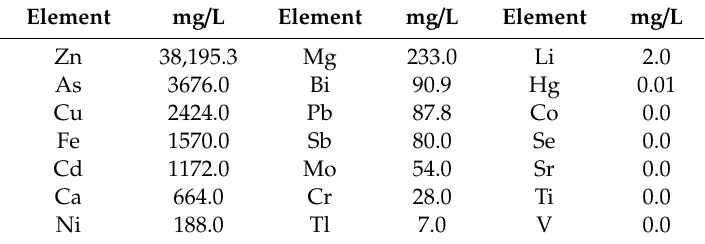
Table 1. Elements contained in the weak acid.